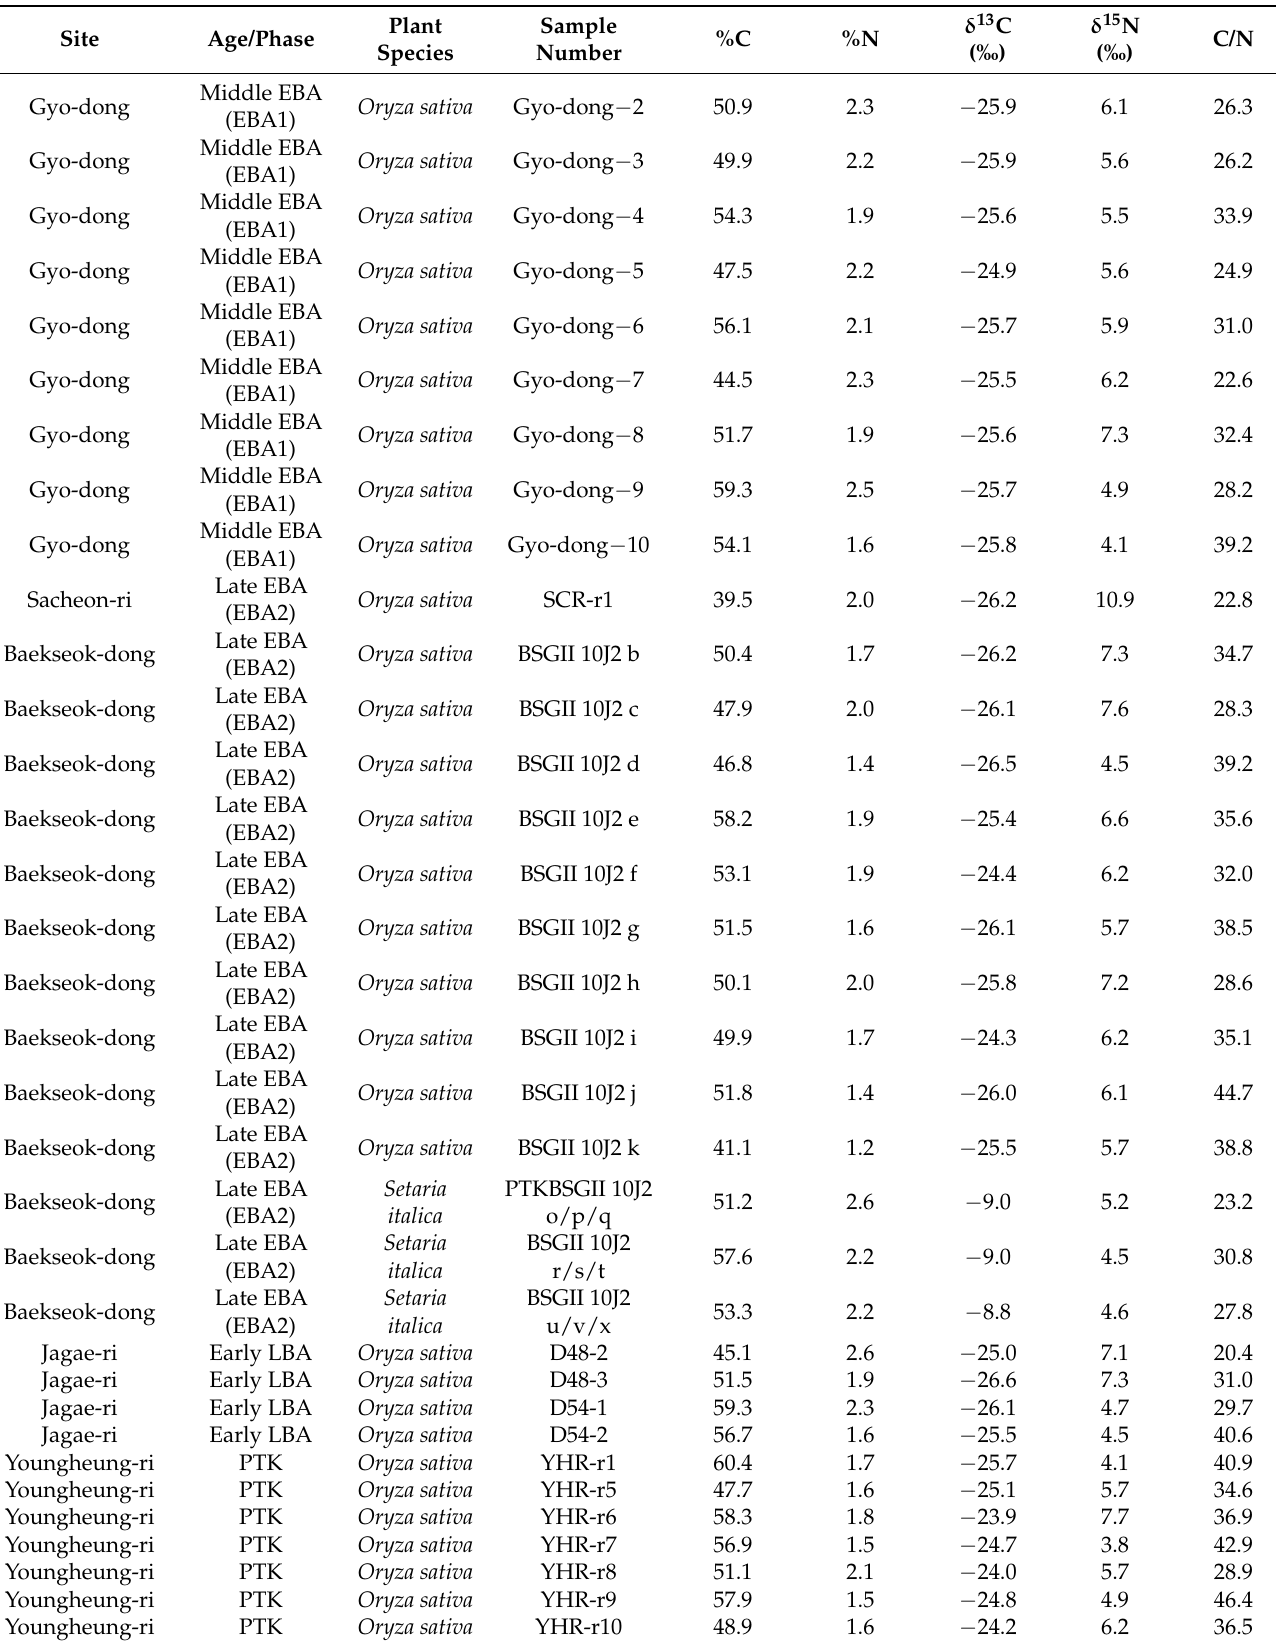
Table 2. Stable carbon and nitrogen isotope values of the charred crop grains analyzed in this